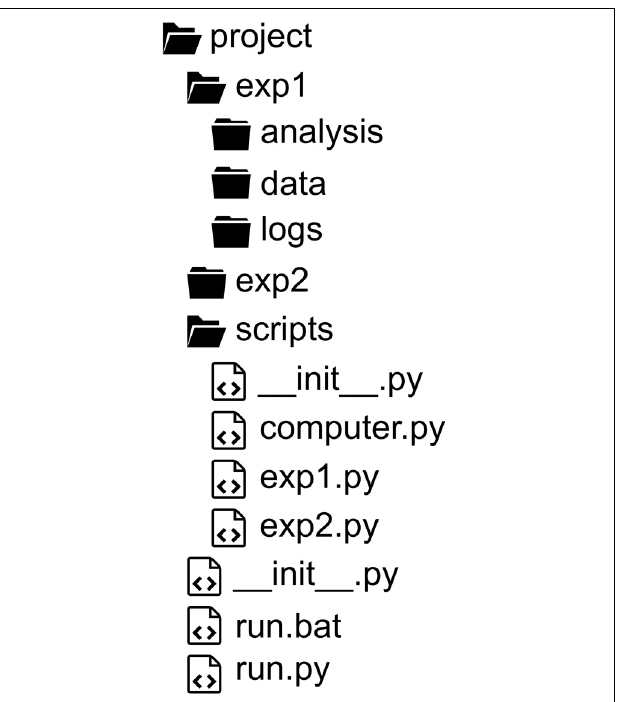
FIGURE 2 | A recommended project